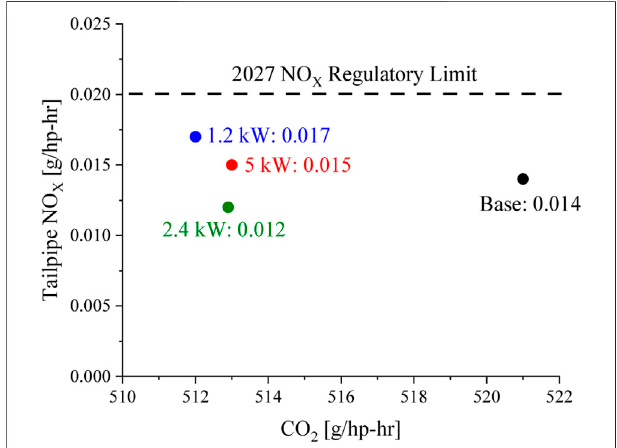
FIGURE 2 | Composite FTP